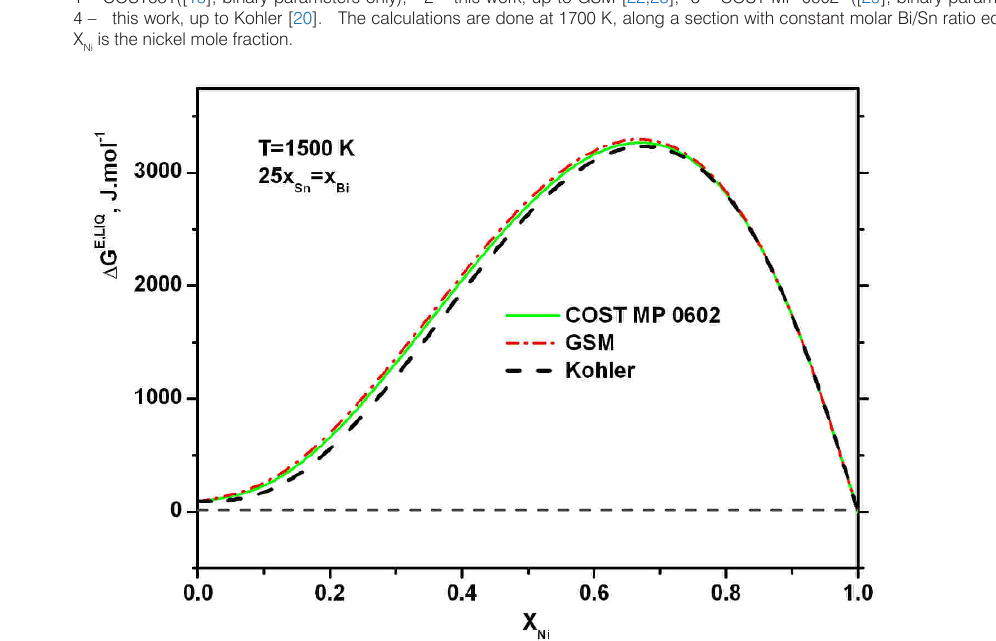
Figure 4. Ternary liquid phase molar Gibbs excess energies ( ∆ G E,Liq , J mol -1 ) calculated in this work according to various techniques: solid line – COST MP 0602 ([29], binary parameters only), dash-dot line – this work, up to GSM [22,23], dashed line – this work, up to is the nickel mole Kohler [20]. The calculations are done at 1500 K, along a section with constant molar Bi/Sn ratio equal to 25/1. X Ni Fig. 3 represents ternary integral molar Gibbs Ni-Sn liquid phase parameters [29 ] were used to excess energies assessed along a molar Bi/Sn ratio calculate the ∆G E values, represented by curves 2 123 equal to 3/1, at 1700 K. In this case, the ∆G E – 4. Small positive values of the ternary molar integral values 123 Gibbs excess energy were observed close to the were positive in the Bi-rich region (up to around 15 at. Sn-Bi region. The shapes of the curves at sections with % Ni) and in the Ni-rich melts. The trend toward positive constant molar Bi/Sn equal to 1 were similar. deviations from the Raoult’s law risess with the increase